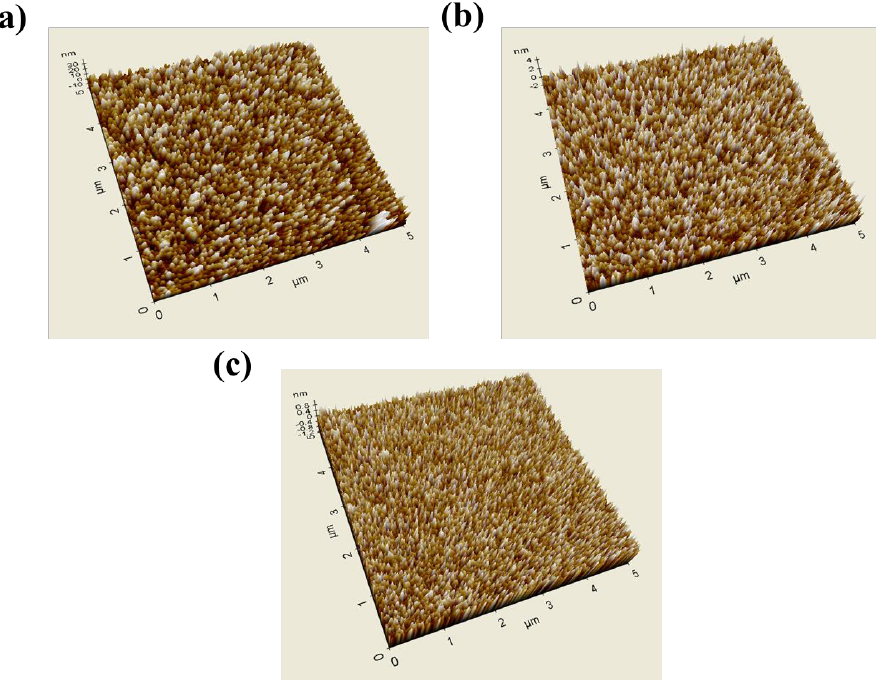
Figure 2. A conditional heat treatment of an a-IGZO thin film. With analysis of the AFM surface roughness, ( a , b ) typical heat treatment was carried out at 200 °C and 300 °C for 1 h, and ( c ) microwave heat treatment was carried out at 200 °C for 10 min. Table 1. Summarized electrical characteristics of the a-IGZO TFT for various annealing